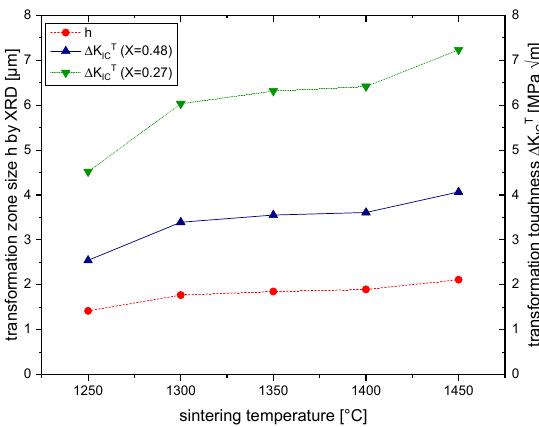
Figure 9. Transformation zone size h, transformation toughness increments Δ K ICT .